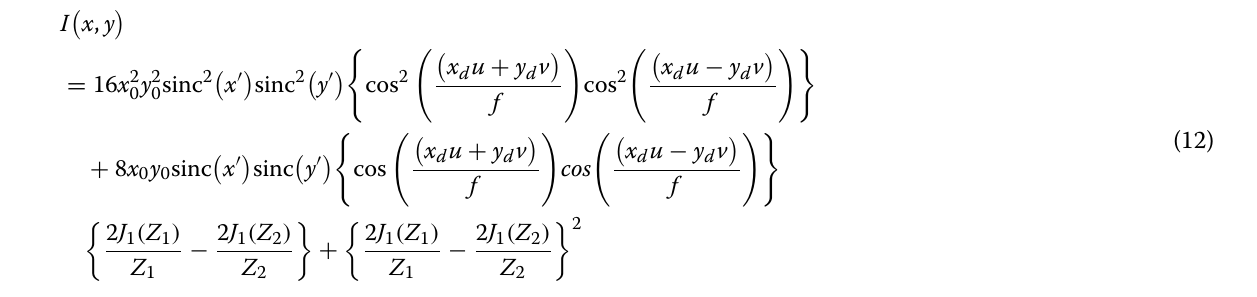
The autocorrelation of the apertures shown in the Fig. 1a–d are computed and plotted as shown in the Fig. 6a–d, where the total band width 1280 pixels which = is two times the aperture width of 640 pixels.